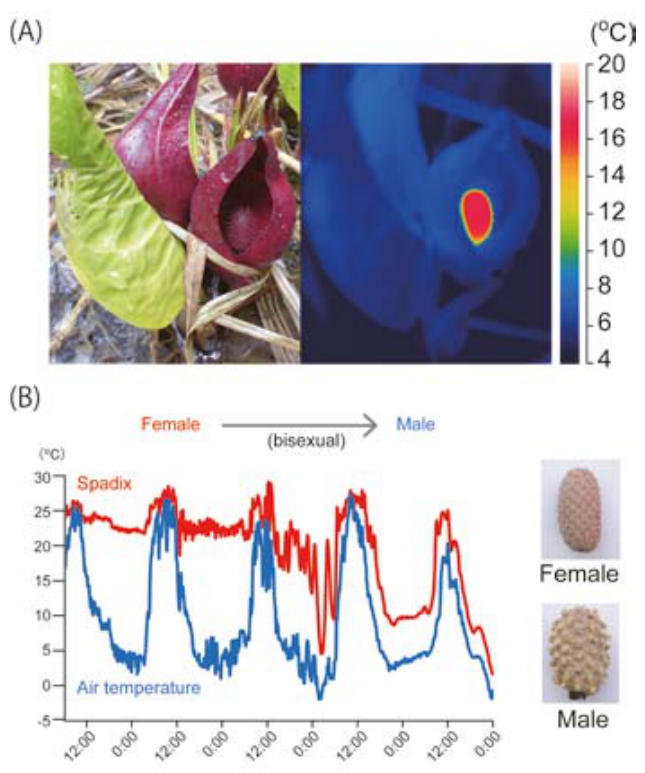
Fig. 1 - Thermoregulation in skunk cabbage ( S. renifolius ). (A) Skunk cabbages were photographed using a camera in the visible (left panel) and infrared spectra (right panel). The thermal image was taken with Thermotracer SC620 (FLIR). Heat production was observed in the spadix during the female stage of floral development. (B) The sequential changes in spadix (red) and air (blue) temperatures during floral development from the female to the male stage. Spadices at the female stage can maintain in- ternal temperature at approximately 22-26°C, whereas spadices at the male stage cannot produce heat. Spadices at the bisexual stage between the female and male stages show unstable ther- mogenesis. Photographs of a female- and a male-stage spadix, are shown in the upper right and lower right panels, respec- tively. (B) was partially extracted from figure 1 in our previous paper (Ito-Inaba et al ., 2009